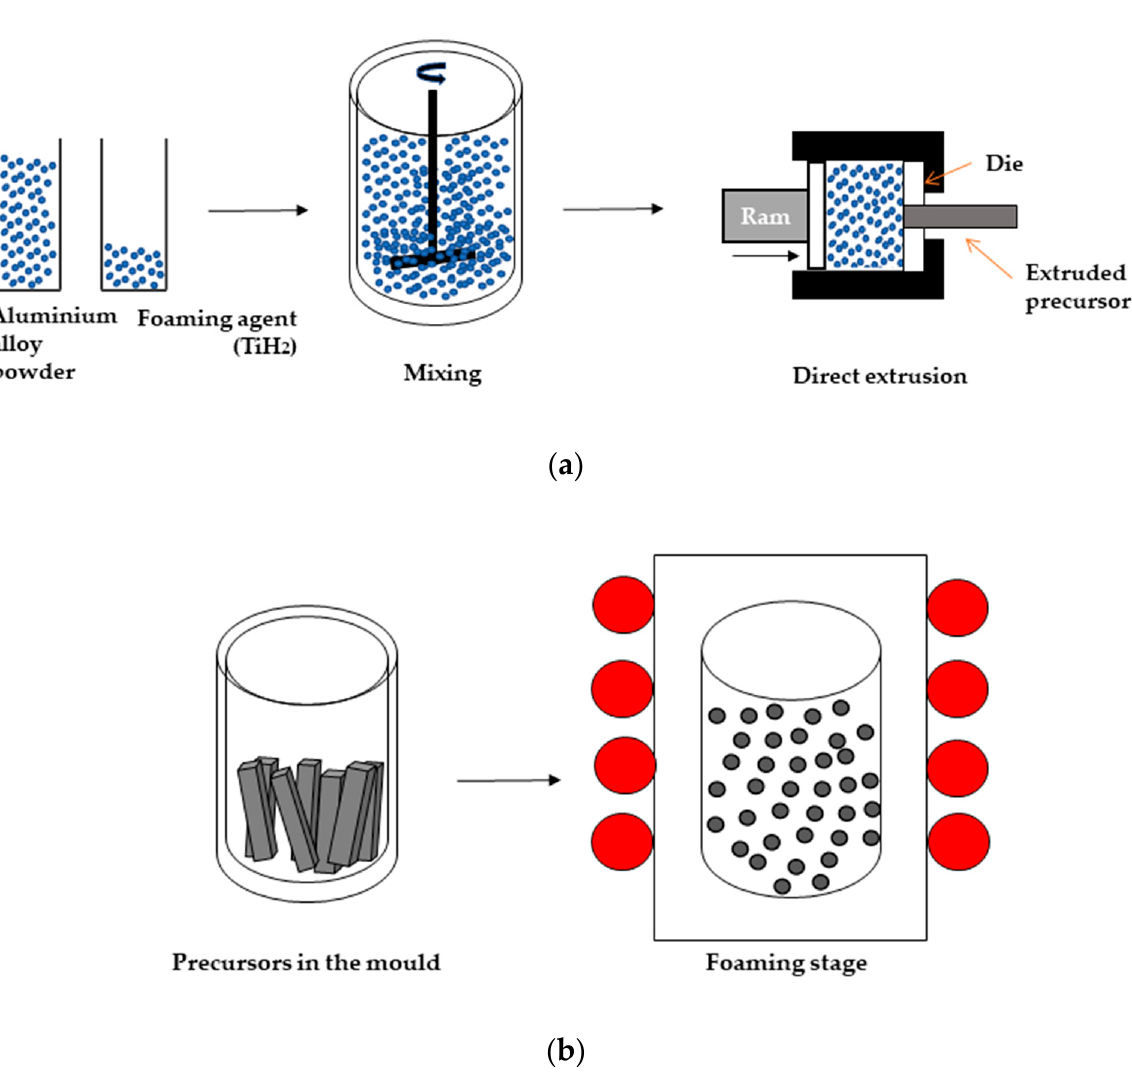
Figure 3. Scheme of AluLight process of the production aluminum foams by gas releasing particles in semi-solids: ( a ) production of precursors, ( b ) production of aluminum foams according to [5].